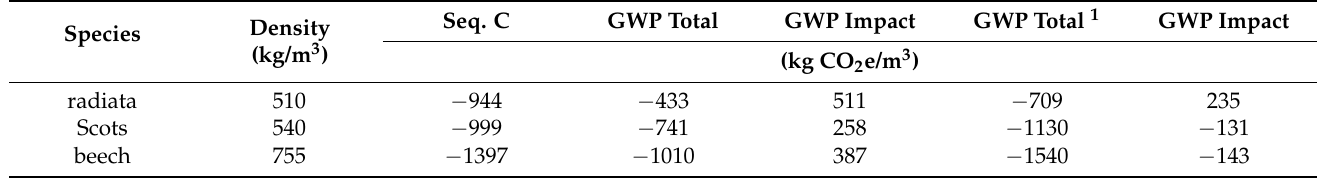
Table 6. Data obtained from the Accoya EPD (NEPD-376-262), the density, sequestered carbon and GWP total were reported in the EPD, whereas the GWP impact was calculated from these data.